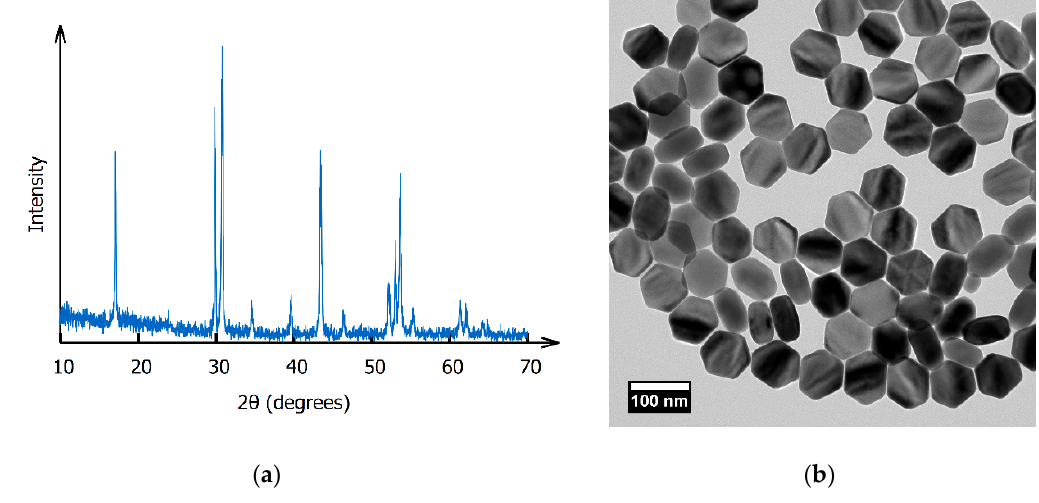
Figure 1. ( a ) XRD pattern of the β -Na(Gd,Lu)F 4 :Tb 3 + nanophosphor; ( b ) TEM image of β -Na(Gd,Lu)F 4 :Tb 3+ nanophosphors. Note that a portion are oriented on their sides.